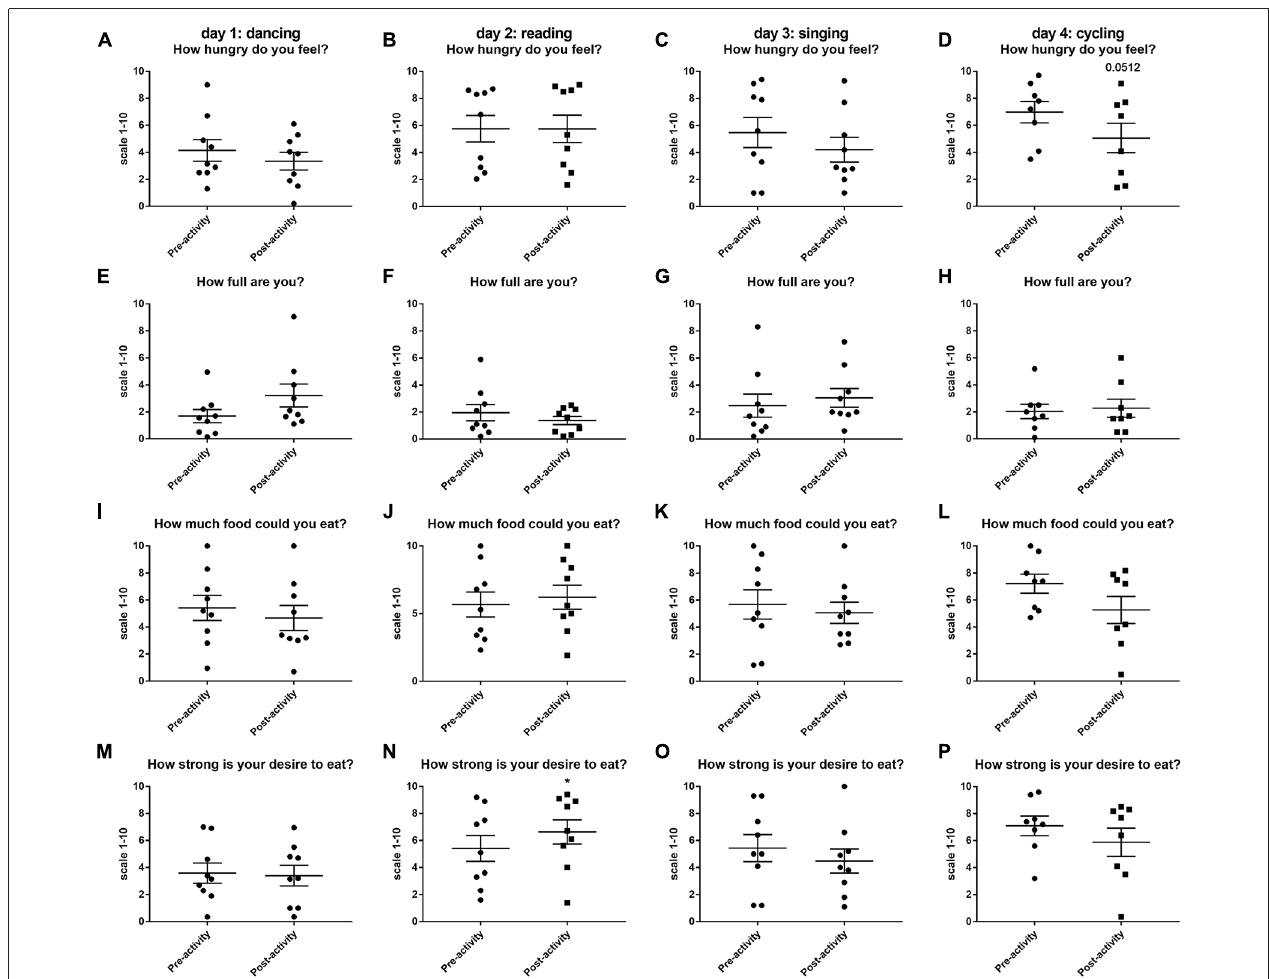
FIGURE 2 | Changes in hunger and appetite scores as assessed using a visual analog scale (VAS) (1–10) before and after 30 min activity (dancing (A,E,L,M) , reading (B,F,J,N) , singing (C,G,K,O) or cycling (D,H,L,P) in nine healthy female volunteers. Data is presented as a scatter plot with mean ± SEM. Data sets were compared by paired Student’s t -test pre and post-activity ( ∗ P <